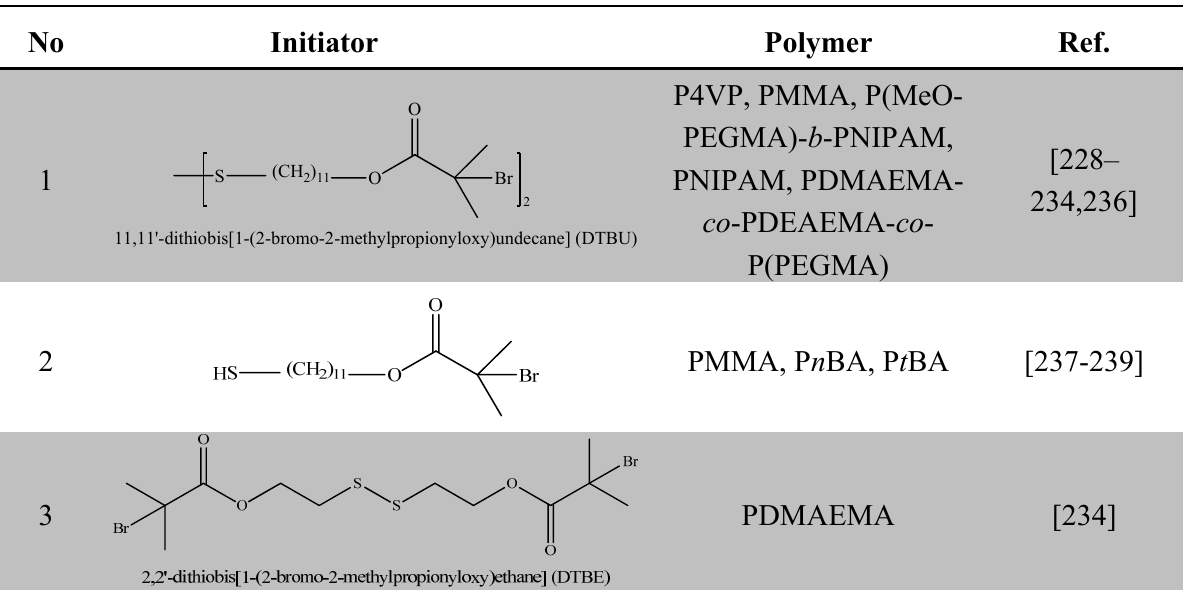
Table 6. ATRP Initiators immobilized on the surface of gold